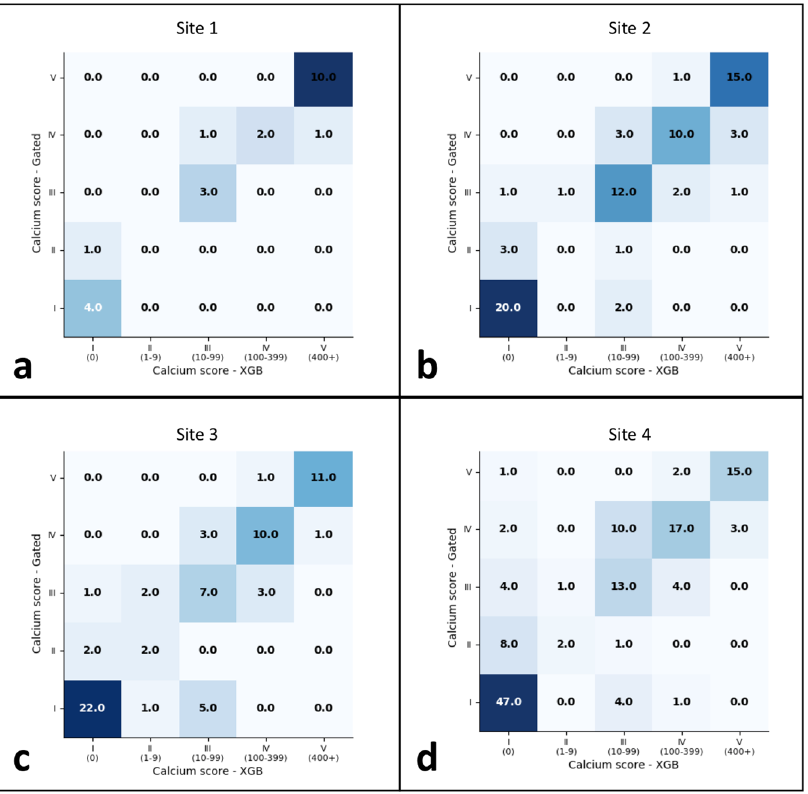
Fig. 6 Comparison of automated and manual CAC scoring on non-gated chest CT exams using four external site datasets. Confusion matrices for the four ( a – d ) external validation datasets comparing automated scoring non-gated chest CT exams to ground truth scores. Ground truth scores are on the y -axis and model prediction are on the x -axis of each